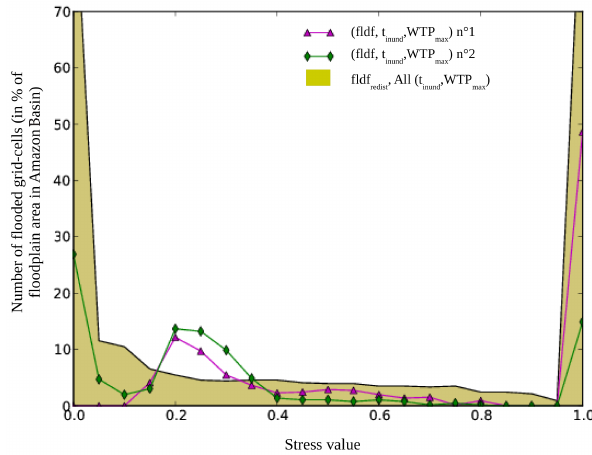
Fig. A6. Distribution of inundation stress on NPP for forests over the Amazon Basin. The percents of floodplain in the Amazon Basin with a given stress value are shown on the y axis. The stress distribu- tion is related to the way to account for fldd (fldd redist or fldd product ) and the value of the (WTP max , t inund ) parameters. In parameter combinations 1 (magenta) and 2 (green), fldd product is used (see Table 1). Yellow area corresponds to the possible range of stress distribution with fldd redist and the (WTP max , t inund ) values.